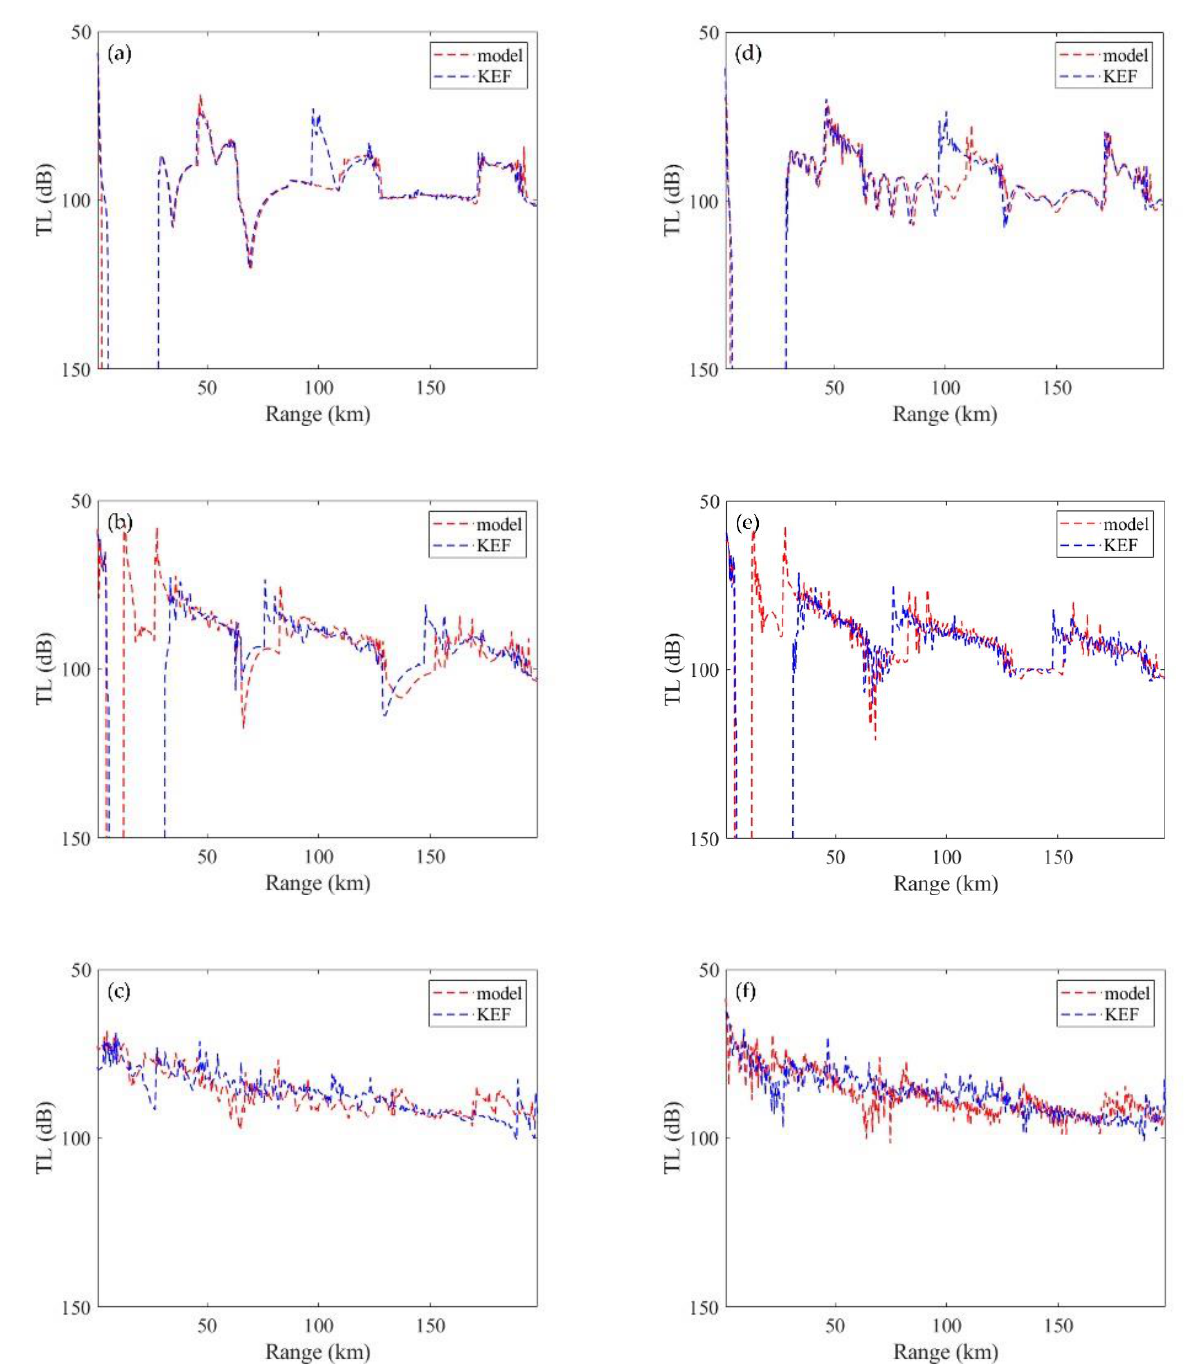
Figure 12. Comparison of the model and actual TL under different SD and frequency on 1 August: ( a ) f = 50 Hz, SD = 100 m; ( b ) f = 50 Hz, SD = 300 m; ( c ) f = 50 Hz, SD = 500 m; ( d ) f = 400 Hz, SD = 100 m; ( e ) f = 400 Hz, SD = 300 m; ( f ) f = 400 Hz, SD = 500 m. When the SD was 100 m, the difference between the TL calculated by the model and the TL calculated by the actual ocean front was very small at low and high frequencies. At 300 m, in terms of the overall distribution trend, the results of the model were similar to the calculation results under the actual ocean front environment. At 500 m, in terms of the overall trend, the results of the model and the actual results also showed many similarities.